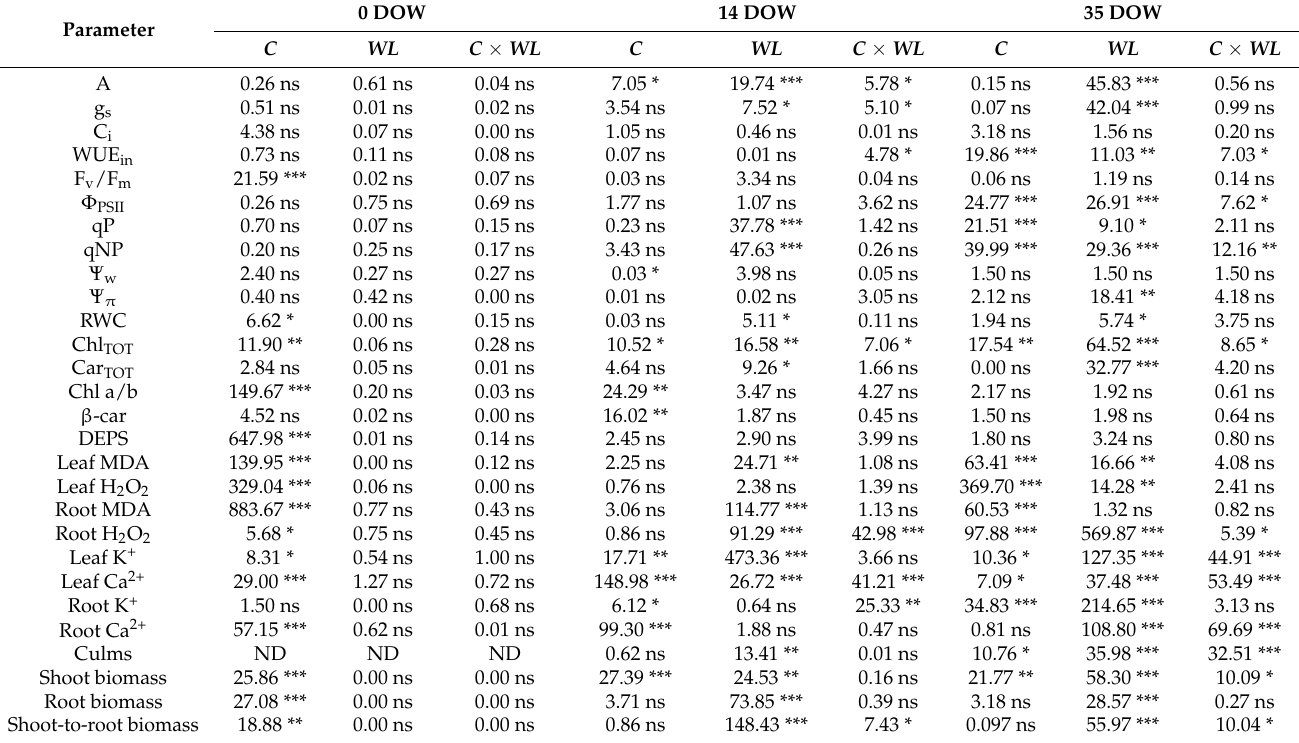
Table 1. Results of two-way analysis of variance (ANOVA) for the effects of cultivar ( C ; degrees of freedom, df: 1), waterlogging ( WL ; df: 1), and their interaction ( C × WL ; df: 1) on water status, and physiological, biochemical, and biometric parameters in durum wheat cultivars Emilio Lepido and Svevo subjected to 0, 14, or 35 days of waterlogging (DOW). Data are F values and p levels (***: p ≤ 0.001, **: p ≤ 0.01, *: p ≤ 0.05, ns: p > 0.05). ND: not determinable (i.e., all plants with one culm per